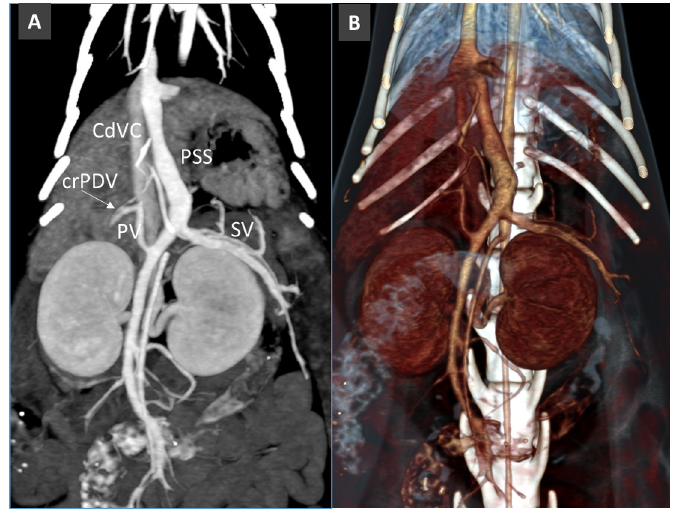
Figure 14. Congenital PSS from left gastric vein in a cat. Note the thin, hypoplastic portal vein (PV). A. Maximum Intensity Projection. B. Volume Rendering.